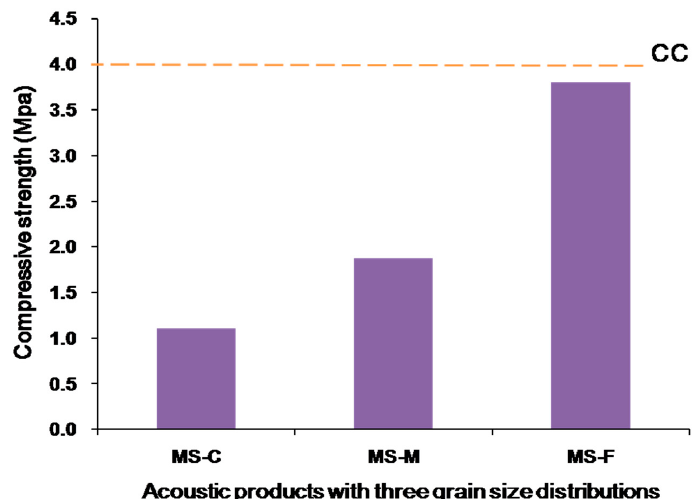
Figure 4. Compressive strength of the three acoustic products compared with coarse porous cement